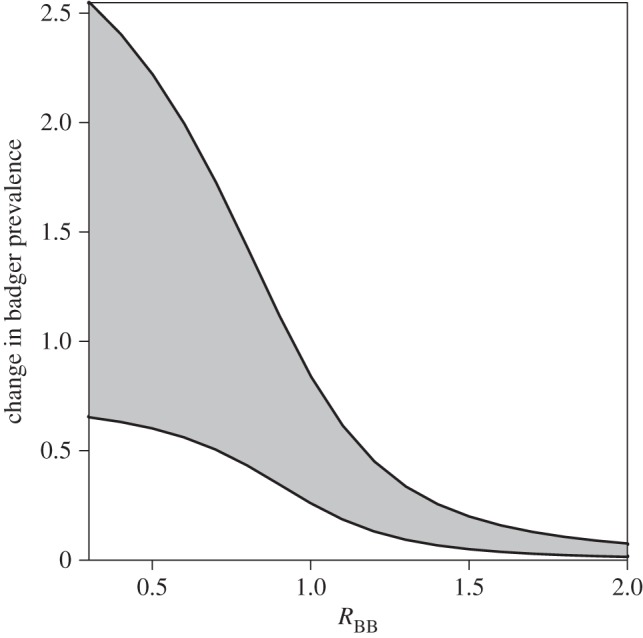
The increase in badger prevalence when cattle removal rate is reduced for values of RBB. The lower line represents the change in badger prevalence when cattle removal decreases from 0.8 to 0.5 years−1 and the upper line represents the change in badger prevalence when the cattle removal rate decreases from 0.8 to 0.2 years−1.